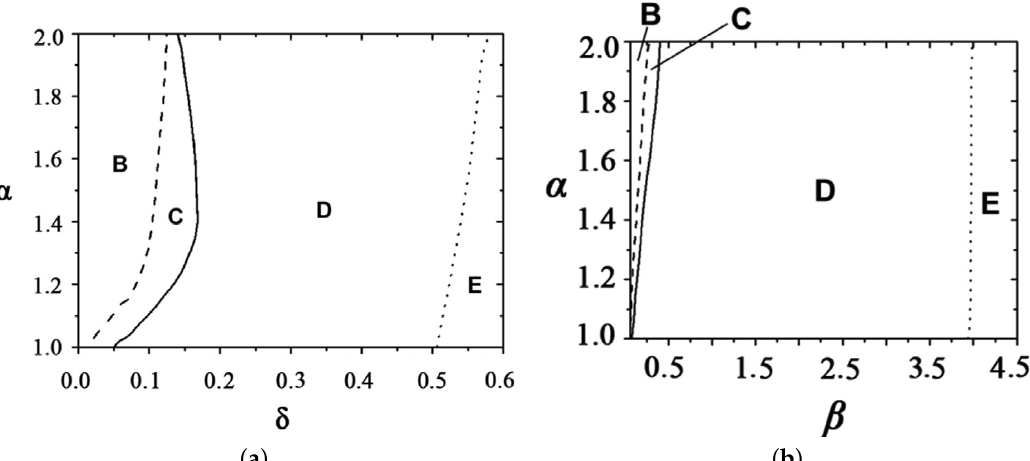
Figure 9. Charts of different established states produced by simulations of the fractional CGLE with the cubic-quintic nonlinearity (35), plotted in planes of the most essential parameters: linear loss δ and Lévy index α (( a ), with fixed β = 0.1), or the fractional-diffusion coefficient β and α (( b ), with δ = 0.1). Other coefficients are ε = 1.7, µ = 1, and ν = 0.115. In the underdamped (low-loss) parameter area B, a uniform state extends, in direct simulations, to occupy the entire spatial domain. In areas C and D, stable dissipative solitons emerge (directly in D and via an initial unstable-evolution stage in C). The input decays to zero in the overdamped area E. Reprinted with permission from Reference [39]. Copyright 2020 Elsevier.